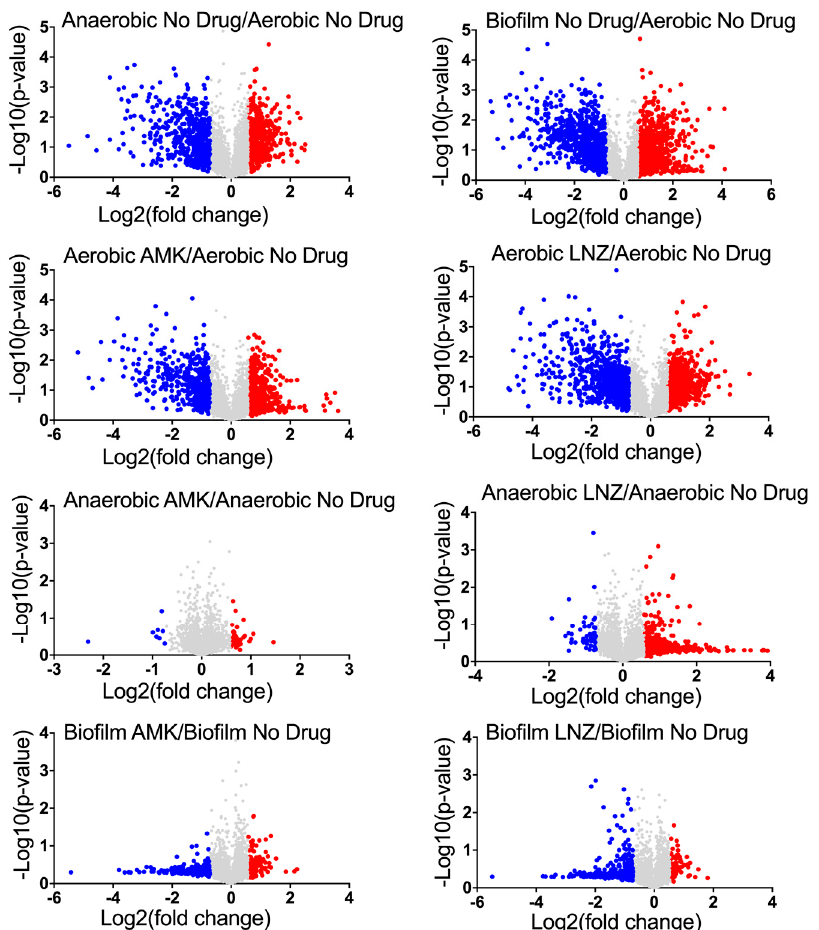
Figure 2. Volcano plots displaying MAB induced or repressed proteins with and without drug treatments. This plot displays the log2 changes in protein synthesis induced under anaerobic and biofilm conditions when compared with the aerobic control. Protein enrichments of AMK or LNZ treated MAB are compered to proteome obtained under the corresponding condition. Synthesized proteins ≥ 1.5-fold higher than control are shown in red, and ≥ 1.5-fold lower than control are in blue; each dot is one protein.